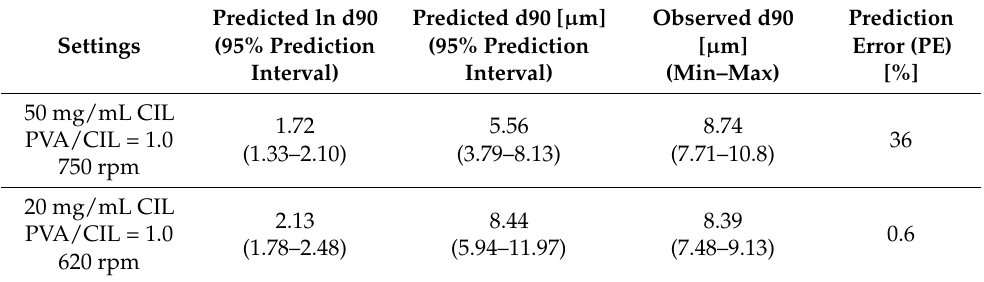
Table A2. Results of validation experiments for the model describing the relationship between LASP process variables and ln d90